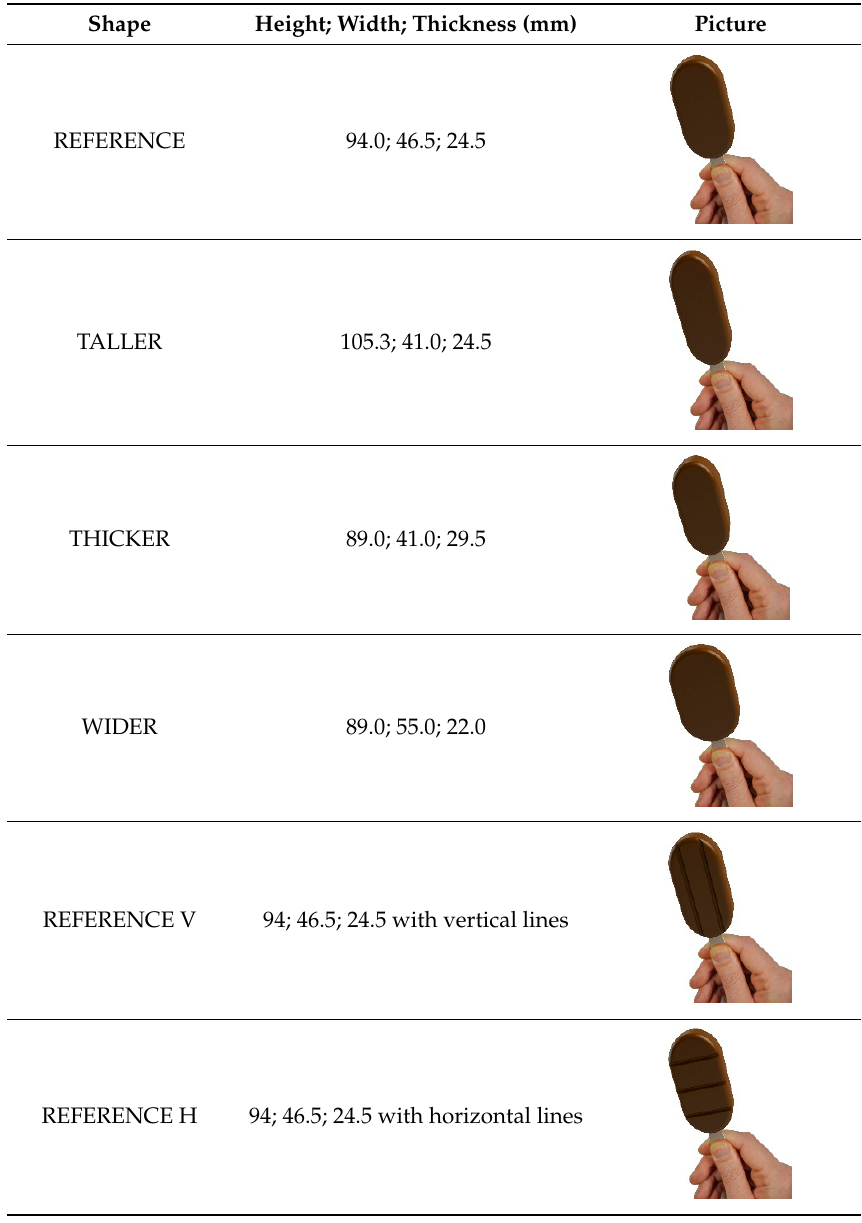
Table 1. Ice cream stick dimensions and pictures for a constant volume of 90 mL.